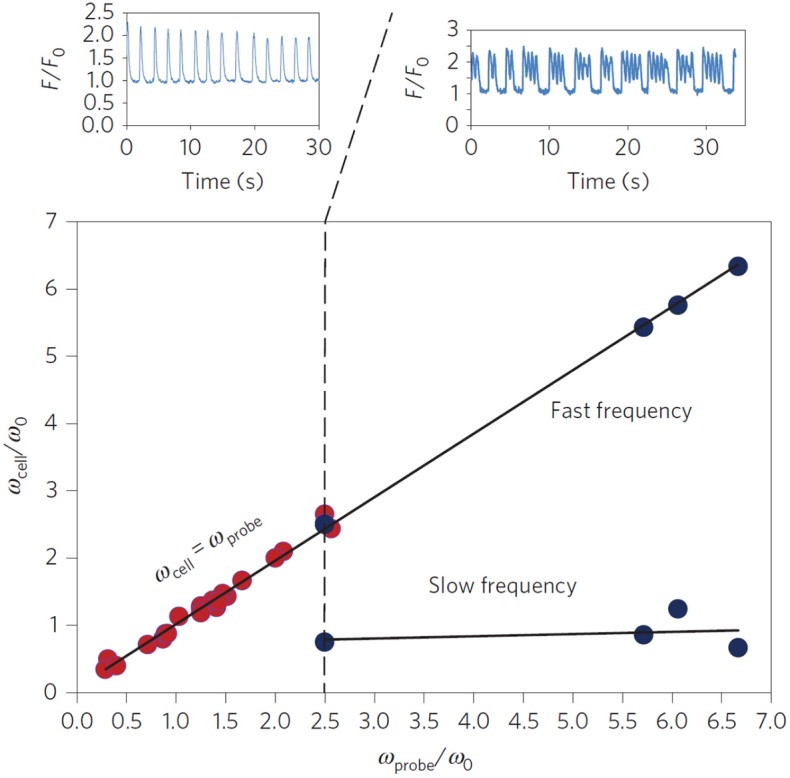
Experimental entrainment of cardiomyocyte beating by a mechanical probe. Isolated cardiomyocytes (n = 30) seeded on an elastic substrate were subject to mechanical pacing by an oscillating inert probe located ~100 μm away from the paced cell. The probe introduced periodic deformations of the underlying substrate with a frequency ωprobe. The cell beating frequency was measured before (ω0) and ~15 min after (ωcell) the pacing probe was activated. The scaled cellular beating frequency (ωcell/ω0) was plotted vs. the scaled probe frequency (ωprobe/ωo) since ω0 varies between cells. Red dots represent full entrainment by the probe, i.e., synchronization to the probe frequency (see top left figure, plotting the scaled fluorescent [Ca2+] signal F/F0 of a representative cell). Blue dots represent “bursting” behavior, where the cell alternates between beating with the frequency of the probe ωprobe and quiescence (see top right figure). The time between consecutive intervals of quiescence was comparable to ω0-1. Reprinted by permission from Springer: Springer Nature (Nitsan et al., 2016).